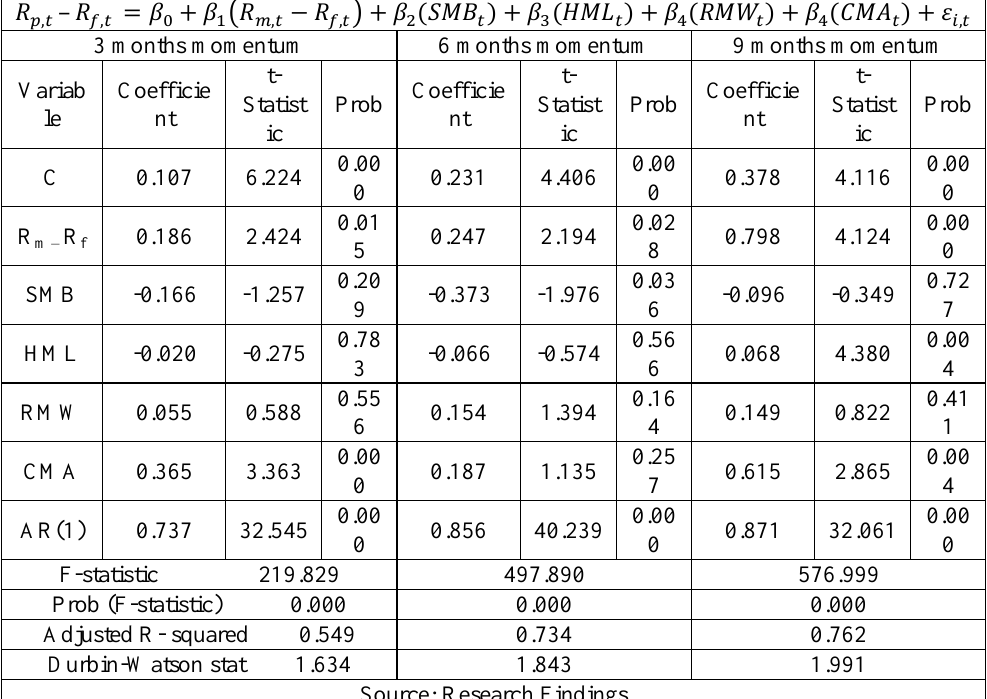
Table 6. Regression results for the disposition effect in stocks with low liquidity on momentum profit using the Fama-French model (